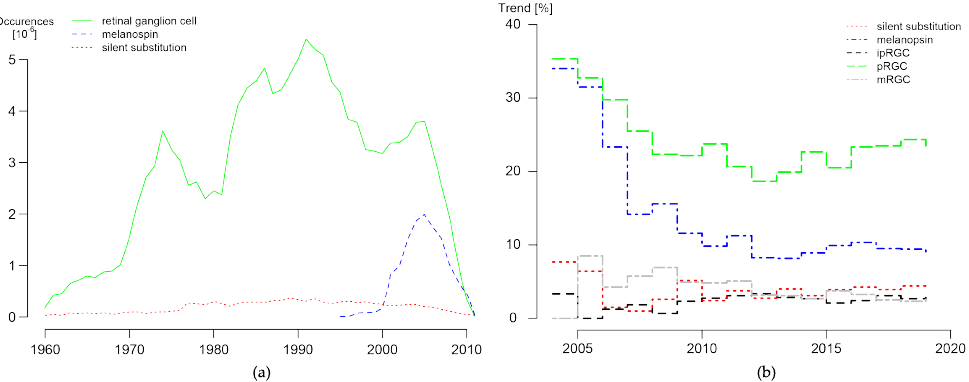
Figure 2. ( a ) Occurrences of selected words within the digitalized books of Google published between 1960 and 2019. ( b ) Yearly means of the monthly relative trends of the selected words from 2004 to 2019. The maximum of 100% occurs in March 2004 for ipRGC .